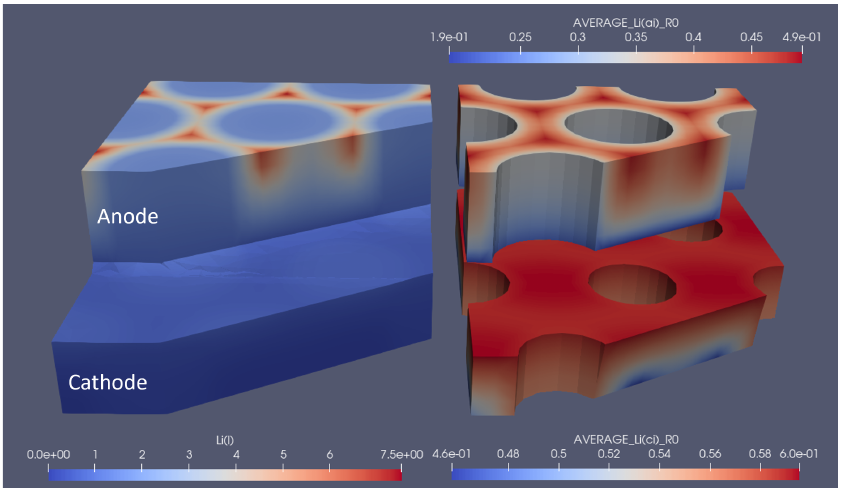
Figure 8. Snapshot of the lithium concentrations in electrolytes and solids for the optimal pinhole structuring at the end of the 3C discharge cycle. The left part shows the concentration in the electrolyte, and the right part shows the average particle concentration in the respective electrodes. 1.9e-01 represents 1.9 × 10 − 1 , the same rule applies to other E